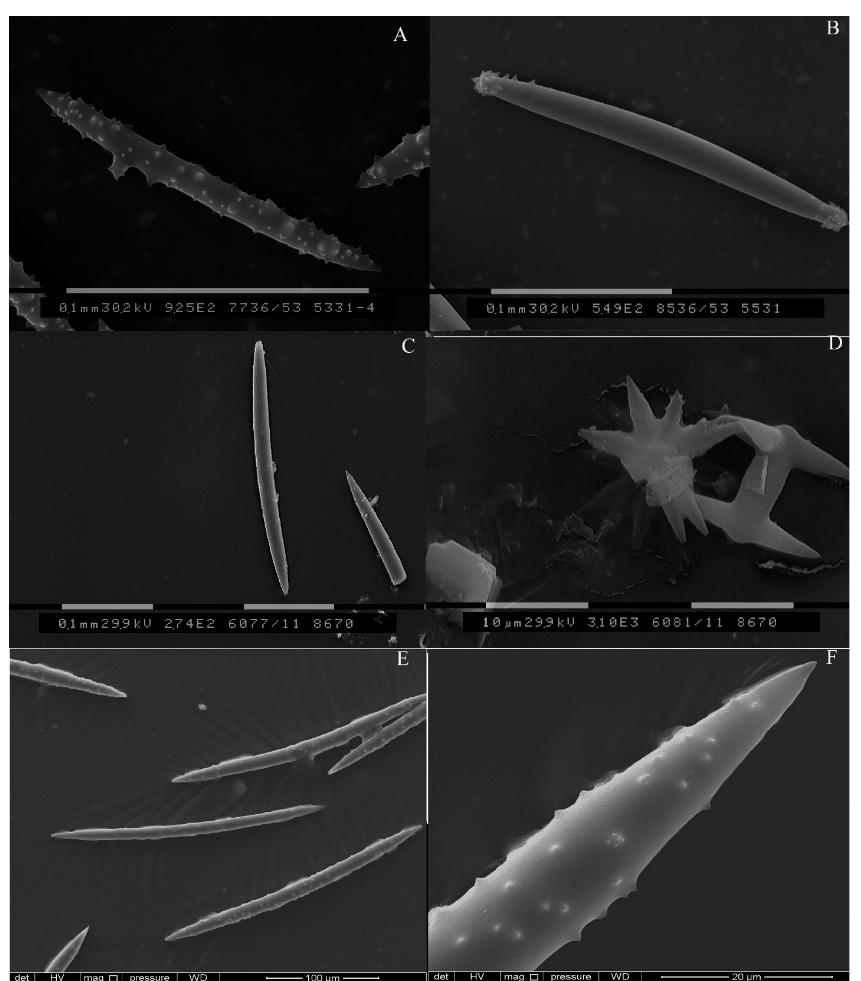
Figure 2. ( A ) megascleres of L. baikalensis ; ( B ) megascleres of B. bacillifera ; ( C ) megascleres of E. muelleri ; ( D ) gemmuloscleres of E.muelleri ; ( E , F ) megascleres of Spongillida sp.